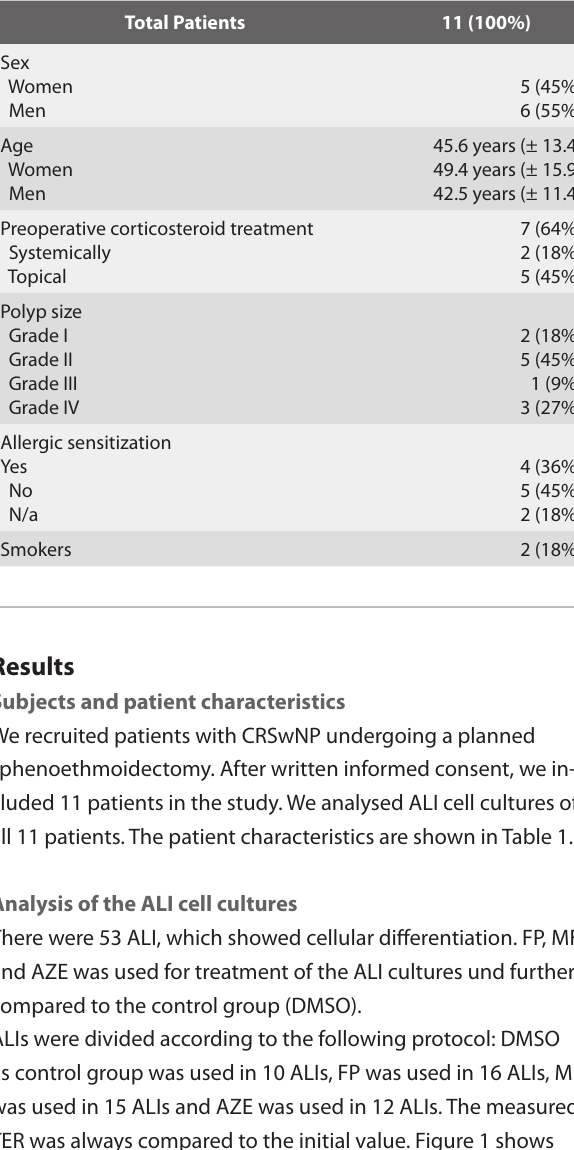
Table 1. Characteristics of the included patients.